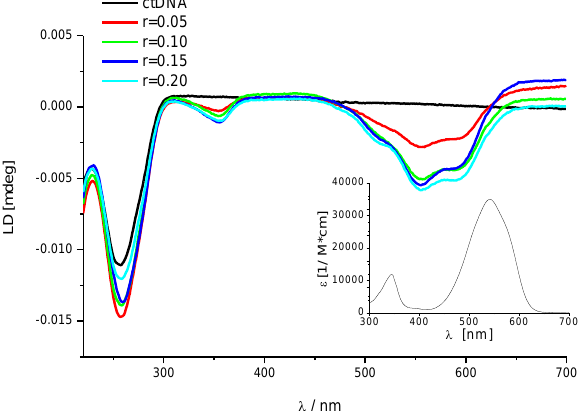
Figure 4. Changes in the flow—linear dichroism (LD) spectra of calf thymus DNA (ct-DNA) ( c = 2 × 10 − 4 mol · dm − 3 ) at various ratios r = [ F1 ] / [ct-DNA]. The induced negative signal in the LD spectra corresponds to the absorption band of F1 , the inset shows F1 UV / vis absorption spectrum.